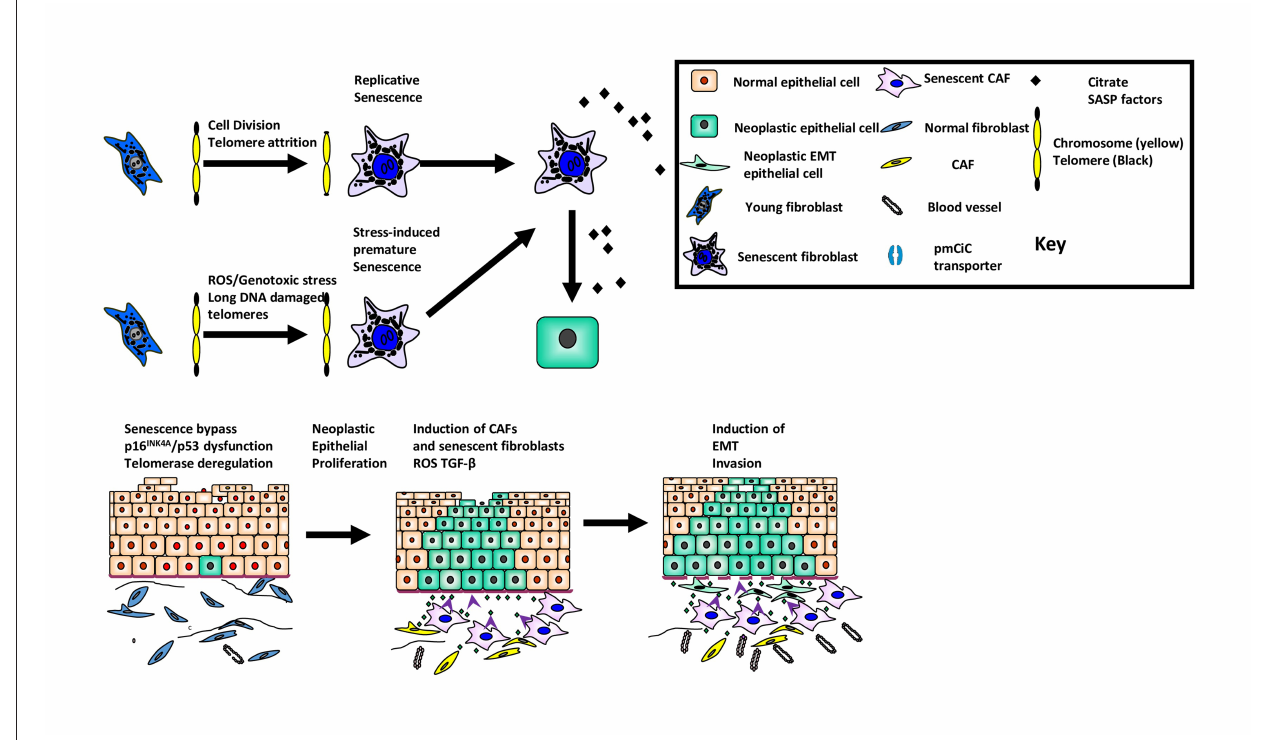
FIGURE 1 | The role of cellular senescence in oral cancer development and progression. The figure summarizes the role of senescence as a suppressor of malignancy in keratinocytes and its paradoxical role as a promoter of tumor progression in the developing tumor